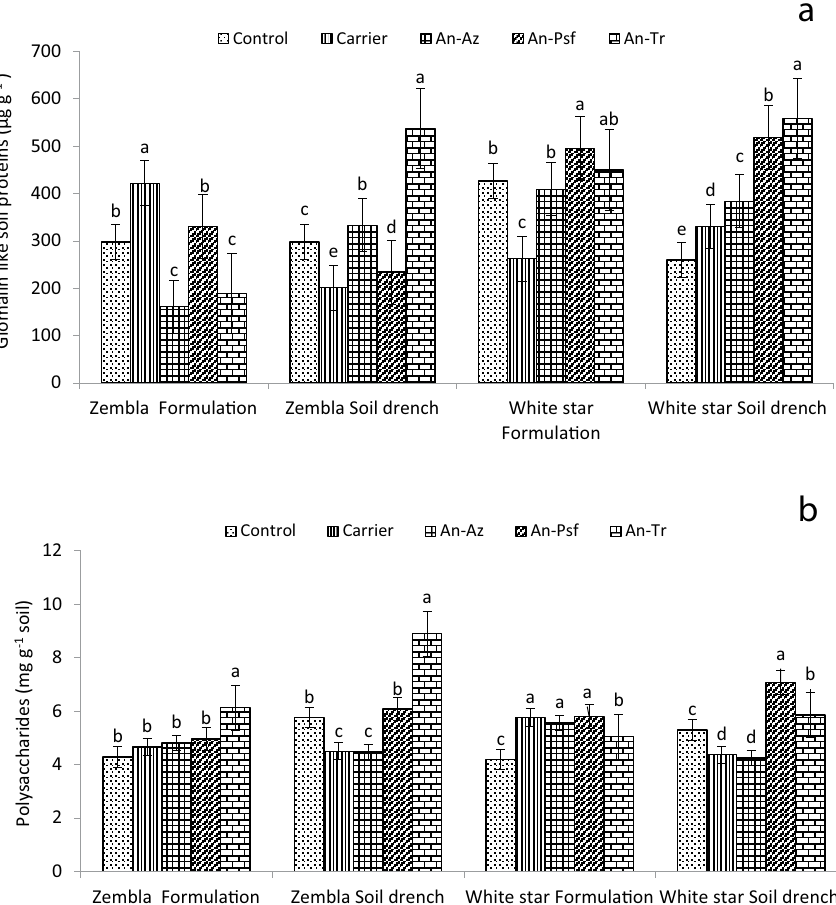
Figure 2: Influence of cyanobacterial biofilm formulations on a. glomalin (GRSPs - Glomalin–like Soil Proteins) content and b. soil poly- saccharide. The treatments include- Control, Carrier, A . torulosa - Azotobacter sp . (An-Az) biofilm, Anabaena torulosa – Pseudomonas fluorescens (An-Psf) biofilm, and Anabaena torulosa – T . viride (An-Tr) biofilm, applied as dry formulation or soil drench. Based on